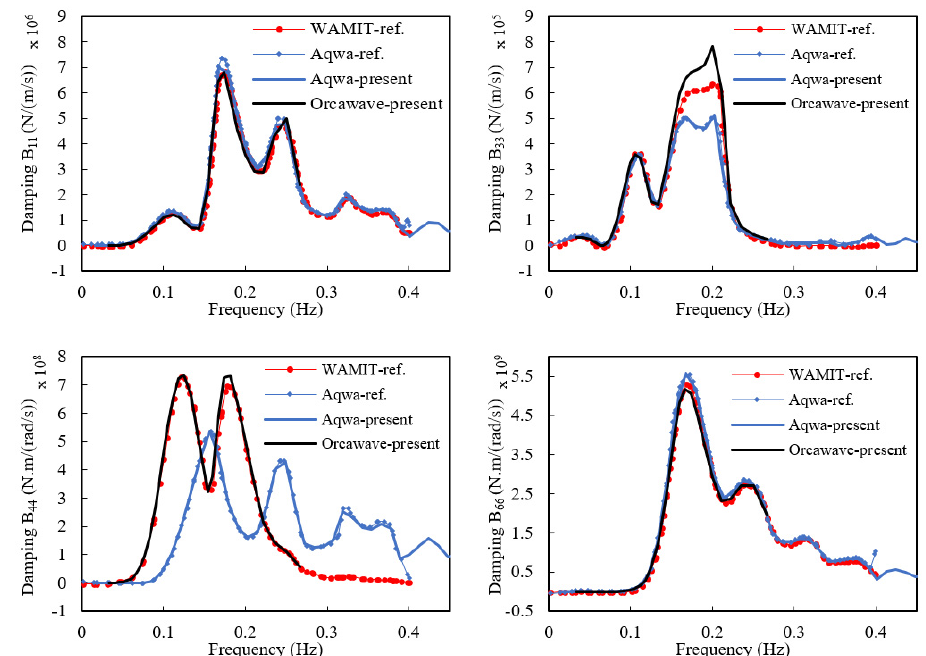
Figure 3. Diffraction analysis technique validation result (damping).